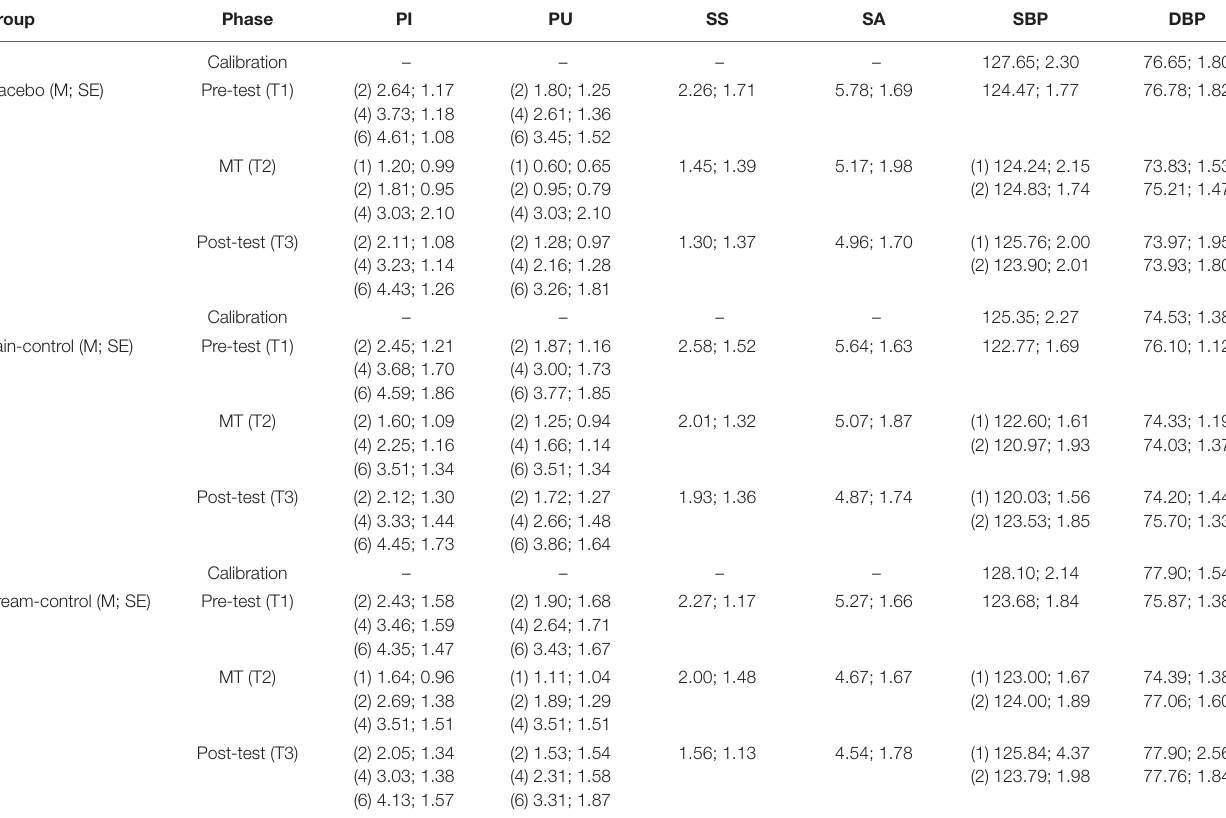
TABLE 2 | Pain intensity, unpleasantness, stress, arousal, systolic, and diastolic blood pressure data across groups and phases. Group